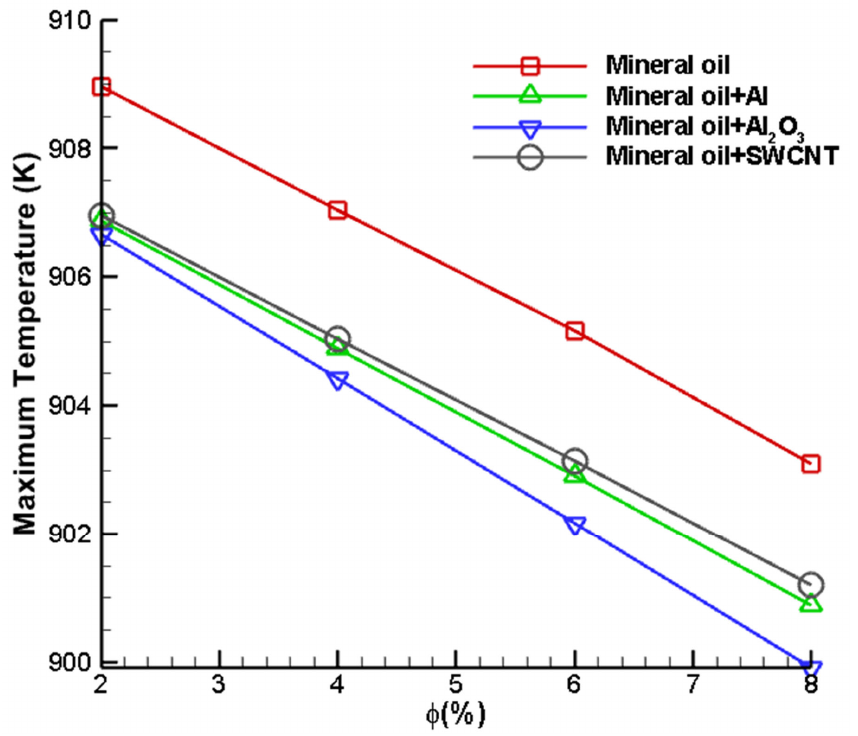
Figure 11. Variation in maximum cutting tool temperature with different volume fractions of dis- persed nanoparticles. The temperature gradient is defined as the change in temperature per unit length. Temperature gradient is a useful parameter which can be used to analyse the rate of change of temperature over a distance. As seen from Figure 12, the temperature gradient for a volume fraction of 2% is highest for SWCNT doped nanofluid. From Table 1, which shows the thermophysical properties of nanoparticles, it is evident that the thermal con ‐ ductivity of SWCNT is 6600 W/m ‐ K, which is more than 30 times greater than the ther ‐ mal conductivities of Al ₂ O ₃ and Al. Hence, the rate of heat transfer is greater for SWCNT doped nanofluid. Moreover, the temperature gradient decreases linearly with the in ‐ crease in volume fraction. Furthermore, it can be seen from Figure 12 that the tempera ‐ ture gradient is nearly the same for Al and Al ₂ O ₃ nanofluids at a volume fraction of 2%. The temperature gradient values of Al ₂ O ₃ and Al nanofluids were found to be 2,729,600 K/m and 2,743,410 K/m, respectively. The temperature gradient on the cutting tool is ob ‐ served to be slightly higher for the Al ‐ mineral oil nanofluid. This trend is mainly ob ‐ served since the thermal conductivity of Al is higher. Furthermore, the difference in the temperature gradient of Al–Mineral Oil and Al ₂ O ₃ –Mineral Oil nanofluids is greater at a higher volume fraction. The temperature gradient of Al–Mineral Oil nanofluid at 8% volume fraction is 2,708,530 K/m. On the other hand, the temperature gradient of Al ₂ O ₃ –